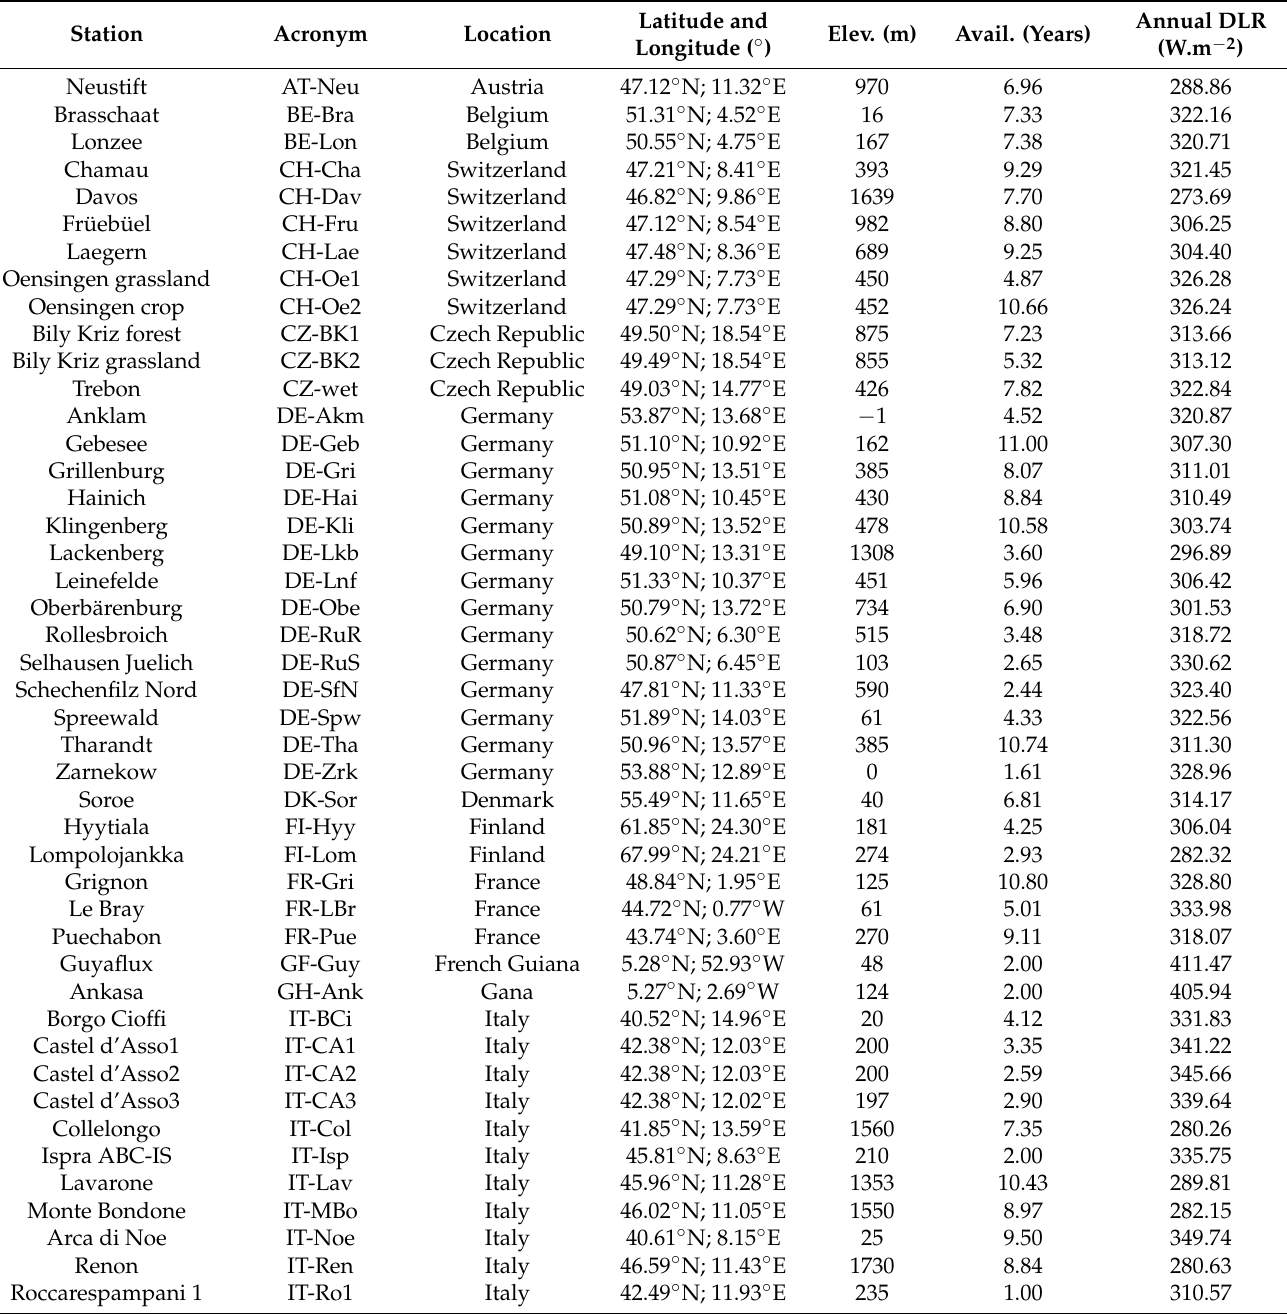
Table A8. List of 52 stations from FLUXNET2015 used within the Meteosat Second Generation (MSG) disk for validation purposes of estimated downward long-wave radiation (DLR) at the surface. The name, acronym, location, geographical coordinates ( ◦ ), elevation (m), availability (total number